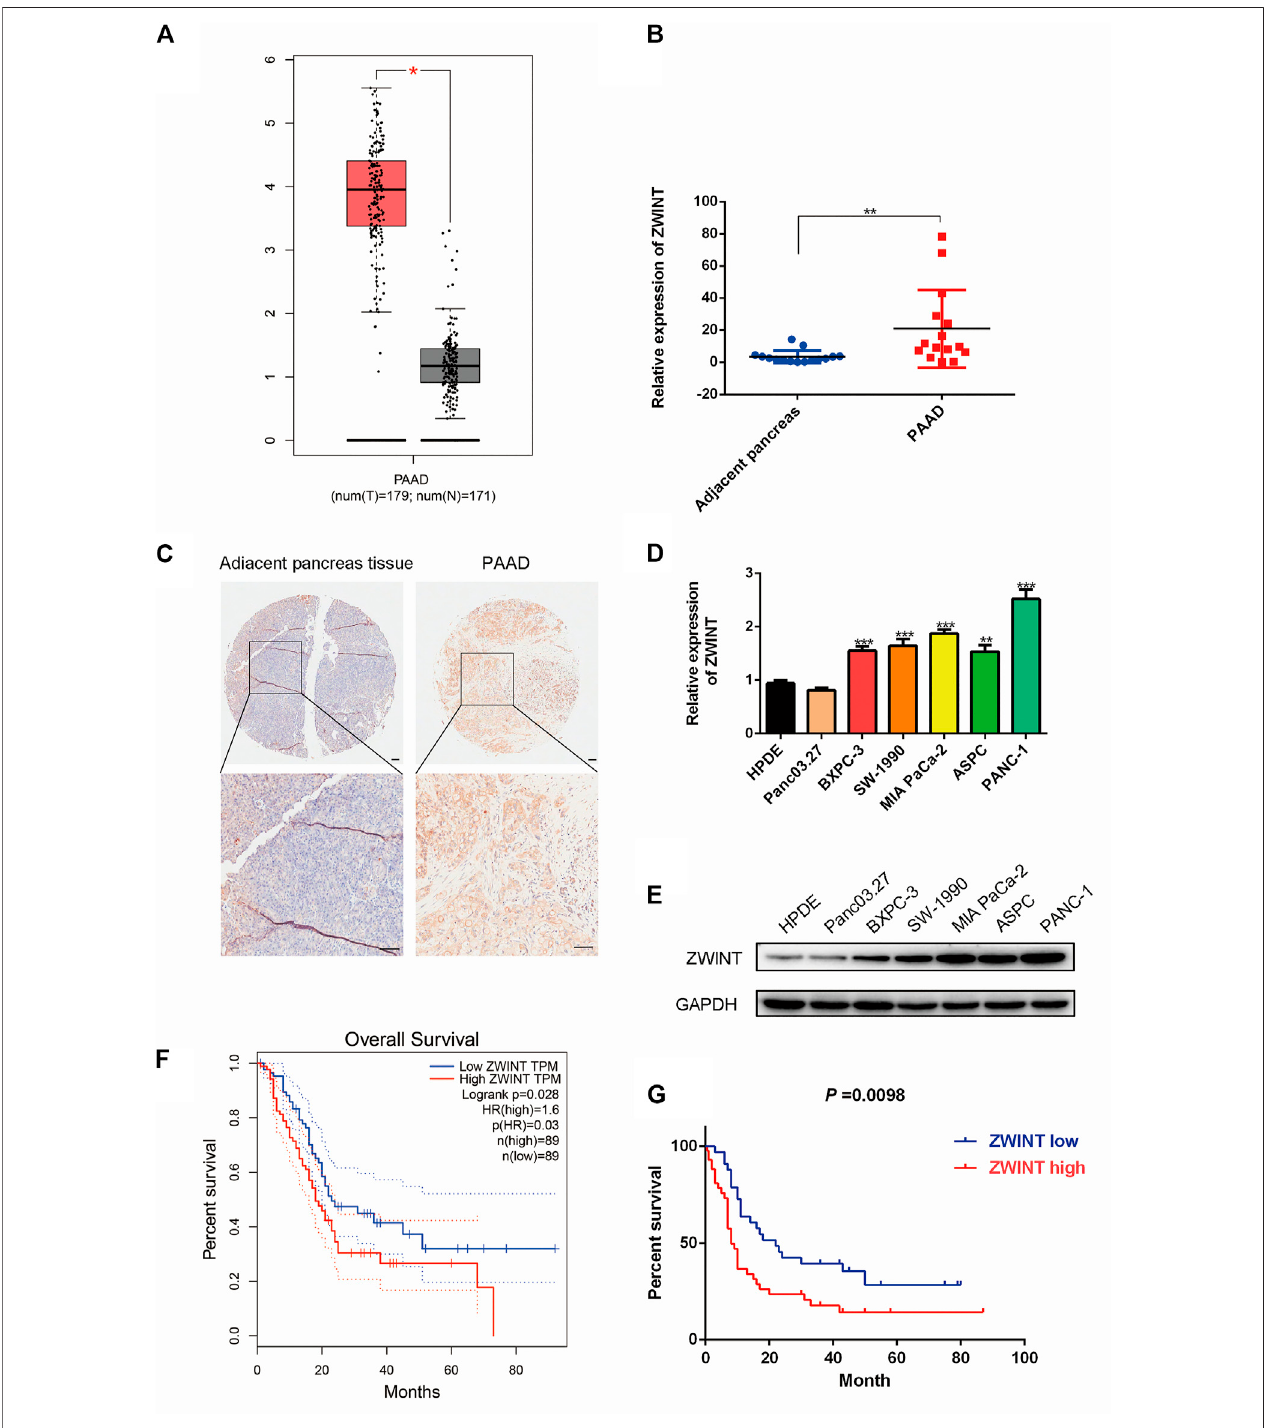
FIGURE 1 | ZWINT was upregulated in pancreatic cancer. (A) . ZWINT expression in TCGA-LIHC database. (B) ZWINT expression in 16 PC tissue samples and paired normal tissue samples by q-RT-PCR. (C) ZWINT expression in tissue microarrays, including 92 pairs of PC samples and adjacent normal tissues. (D, E) q-RT- PCR and western-blot quantitatively analysis of ZWINT expression in normal and PC cell lines. (F) Data in the TCGA database showed the overall survival of the two groups ofpatients with high ( n (cid:2) 60, red line) or low( n (cid:2) 32, blue line) PC expression in colon cancer tissues. (G) Kaplan – Meier representation ofthe overall survival ofthetwogroupsofpatientswithhigh( n (cid:2) 60,redline)orlow( n (cid:2) 32,blueline)ZWINTexpressioninourcohort. (H) ROCanalysisofthecorrelationofZWINTexpression and survival time. All data are the mean ± SD of three independent experiments. * p < 0.05.